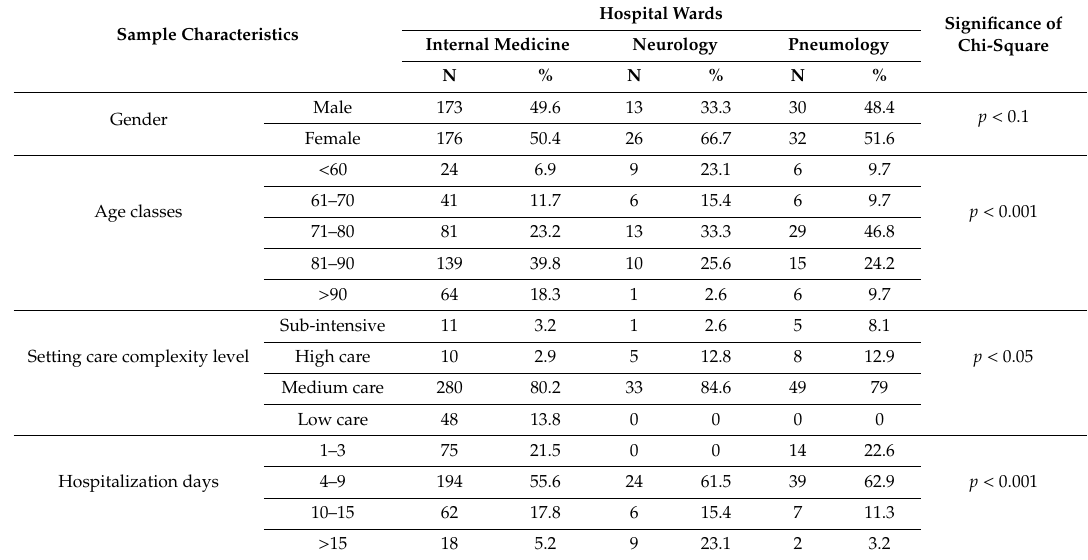
Table 5. Contingency table on the sample characteristic by hospital ward.